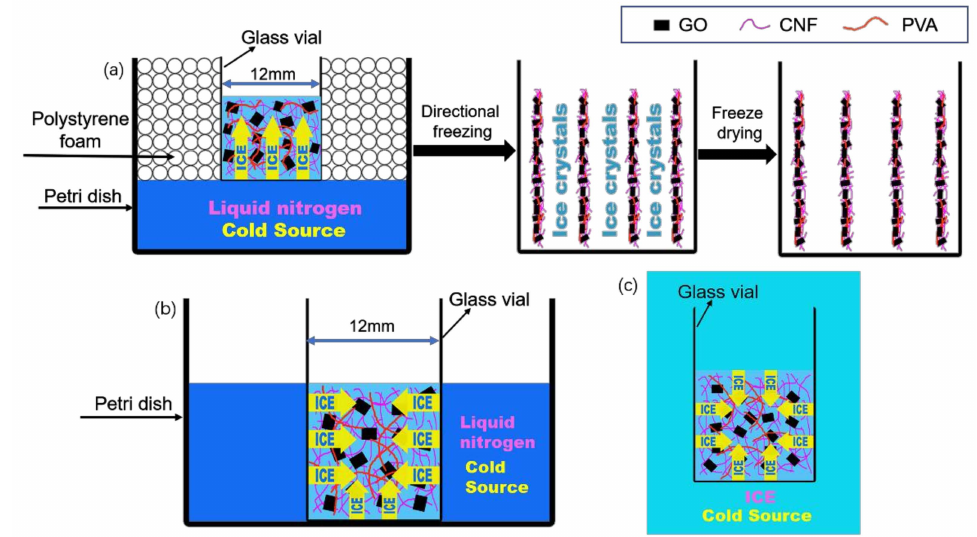
Figure 1. Schematic representation of ( a ) the directional freeze-drying method; ( b ) the non-directional freeze-drying method and ( c ) the refrigerator freeze-drying method. Cellulose nanofiber (CNF); polyvinyl alcohol (PVA); graphene oxide